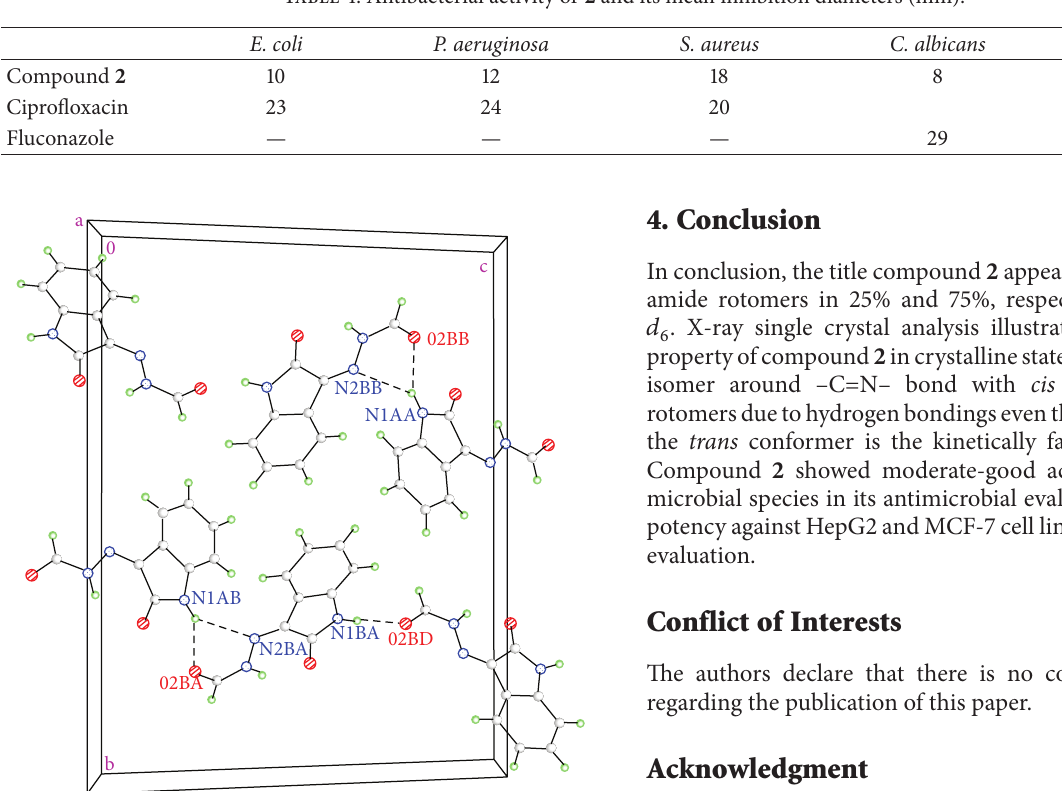
Table 4: Antibacterial activity of 2 and its mean inhibition diameters (mm).